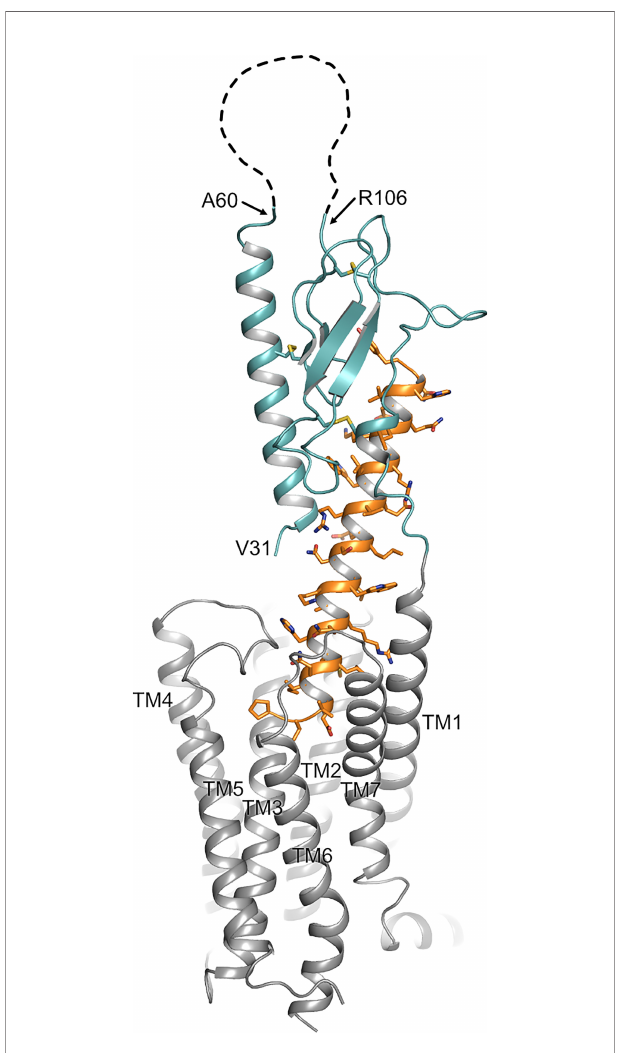
FIGURE 1 | Topology of PTH1R. Structure of the human PTH1R (transmembrane domain, grey; ECD, teal) in complex with a PTH analog (orange) (PDB ID: 6FJ3). Unstructured residues 61-105 of ECD loop 1 are depicted as a dashed line. The receptor N-terminus residue (V 31 , as resolved in the crystal structure), residues embracing ECD loop 1, and transmembrane helices (TM1-7) are